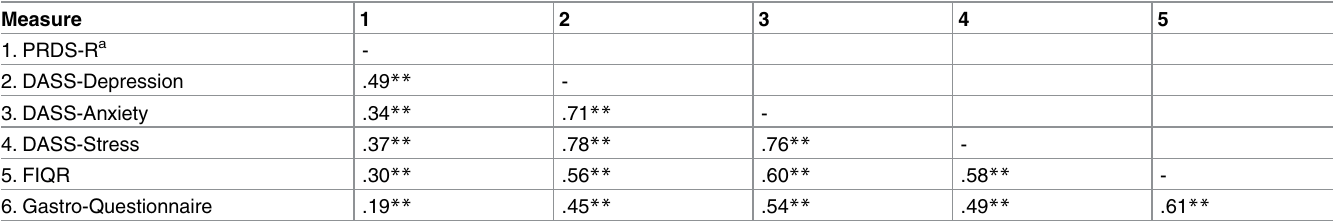
Table 2. Correlation matrix for study